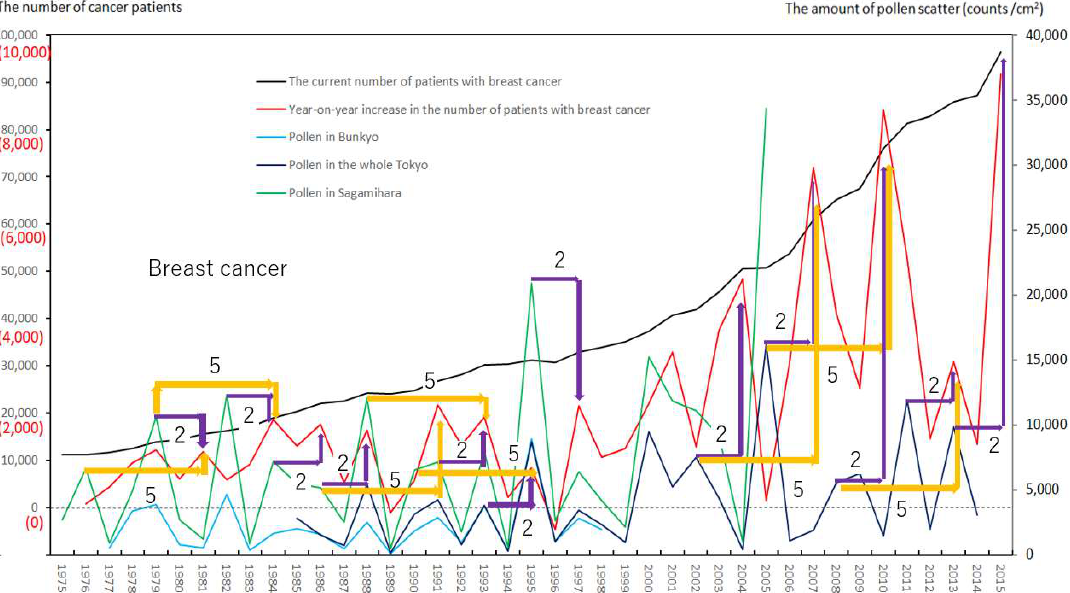
Figure 8. The current number of Japanese females (presently registered patients) registered for breast cancer at the year diagnosed, its year-on-year increase (newly registered patients) and the amount of air borne pollen scatter in 3 areas during the period from 1975 to 2015. The line graphs for females with breast cancer representing numbers of presently and newly registered patients in each year, as well as the amount of pollen scattered during the period from 1975 to 2015. Violet or orange arrows indicate phasic increments of newly registered patients occurring two or five years after phasic increments of airborne pollen scatter, respectively.